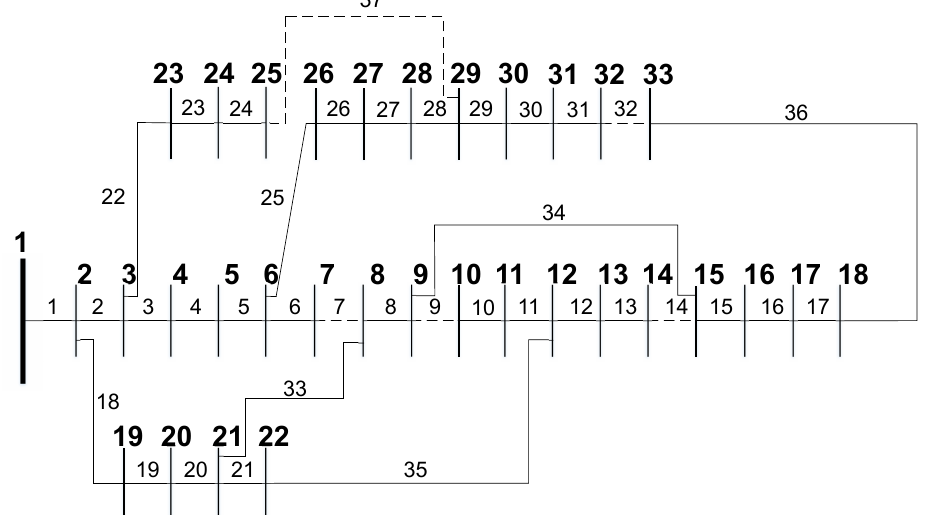
Figure 4. 33-bus and 37-branch system final configuration (fixed).